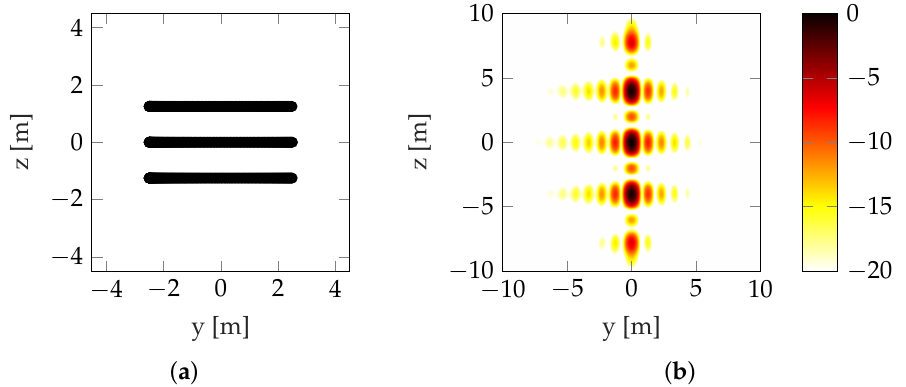
Figure 20. Reference scenario with three passes: ( a ) Trajectory. ( b ) PSF.